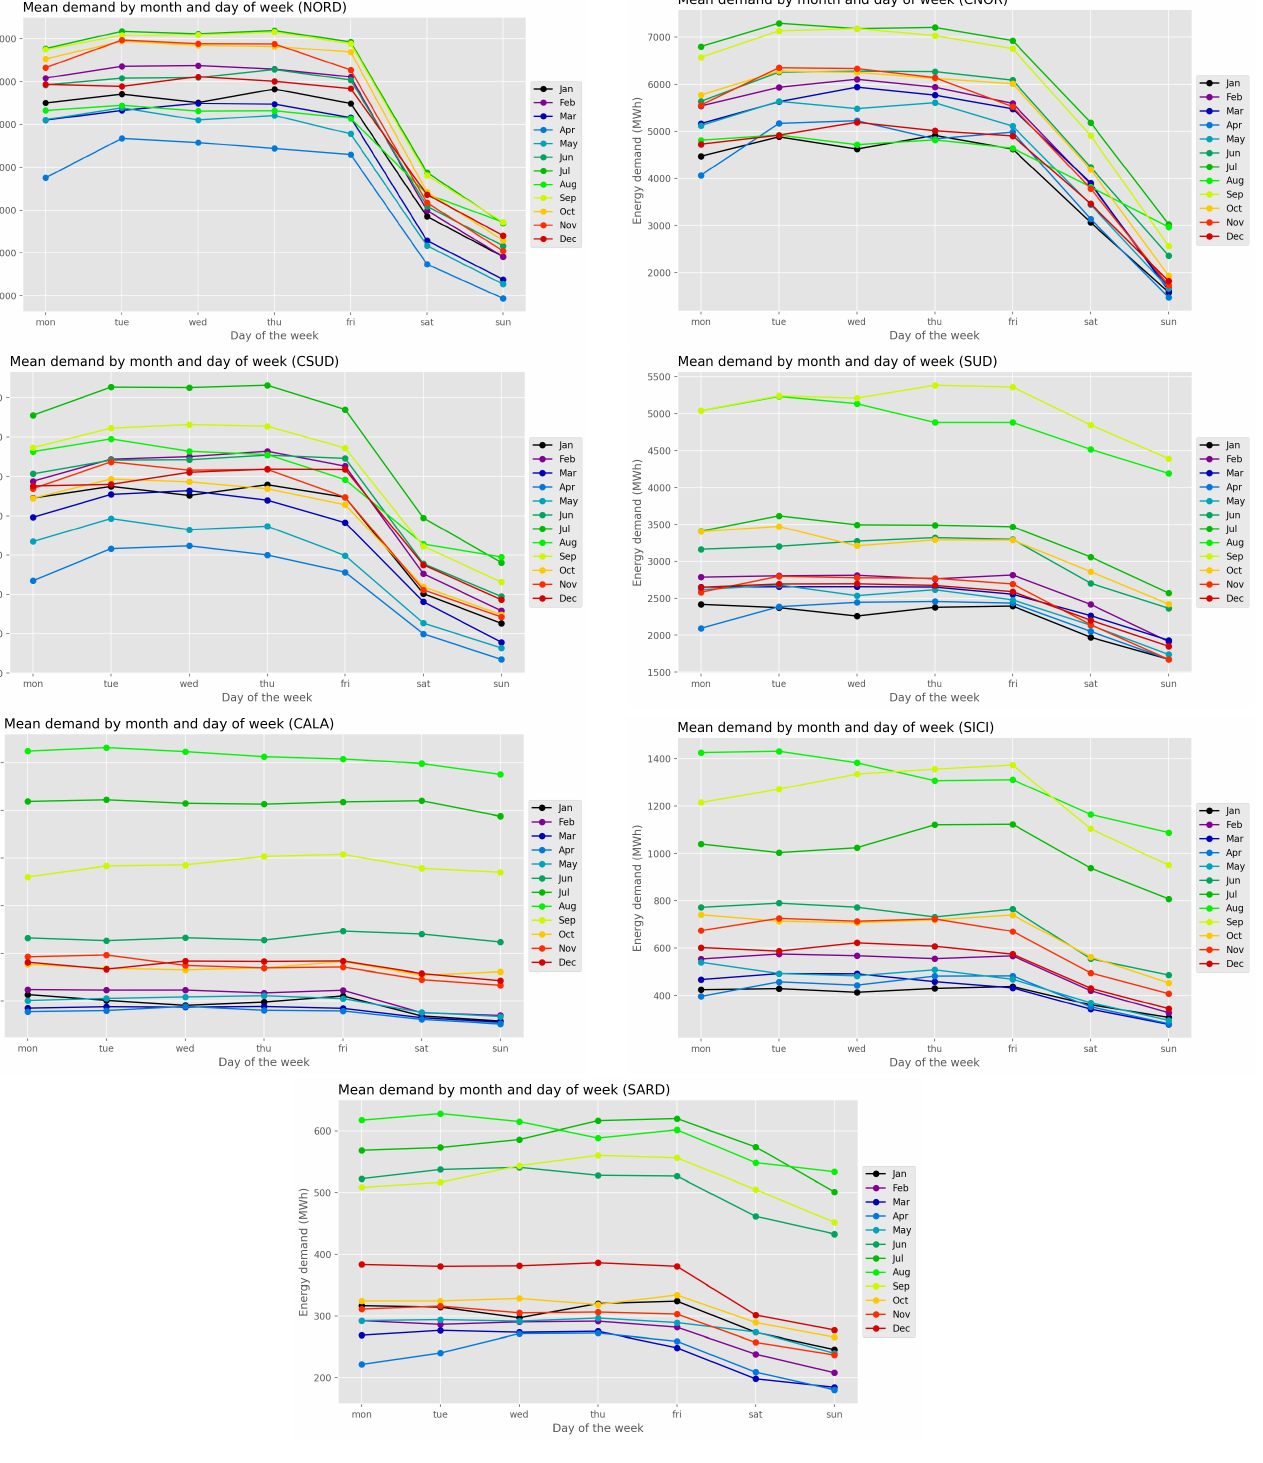
Figure 3. Average demand of energy by month and day of the